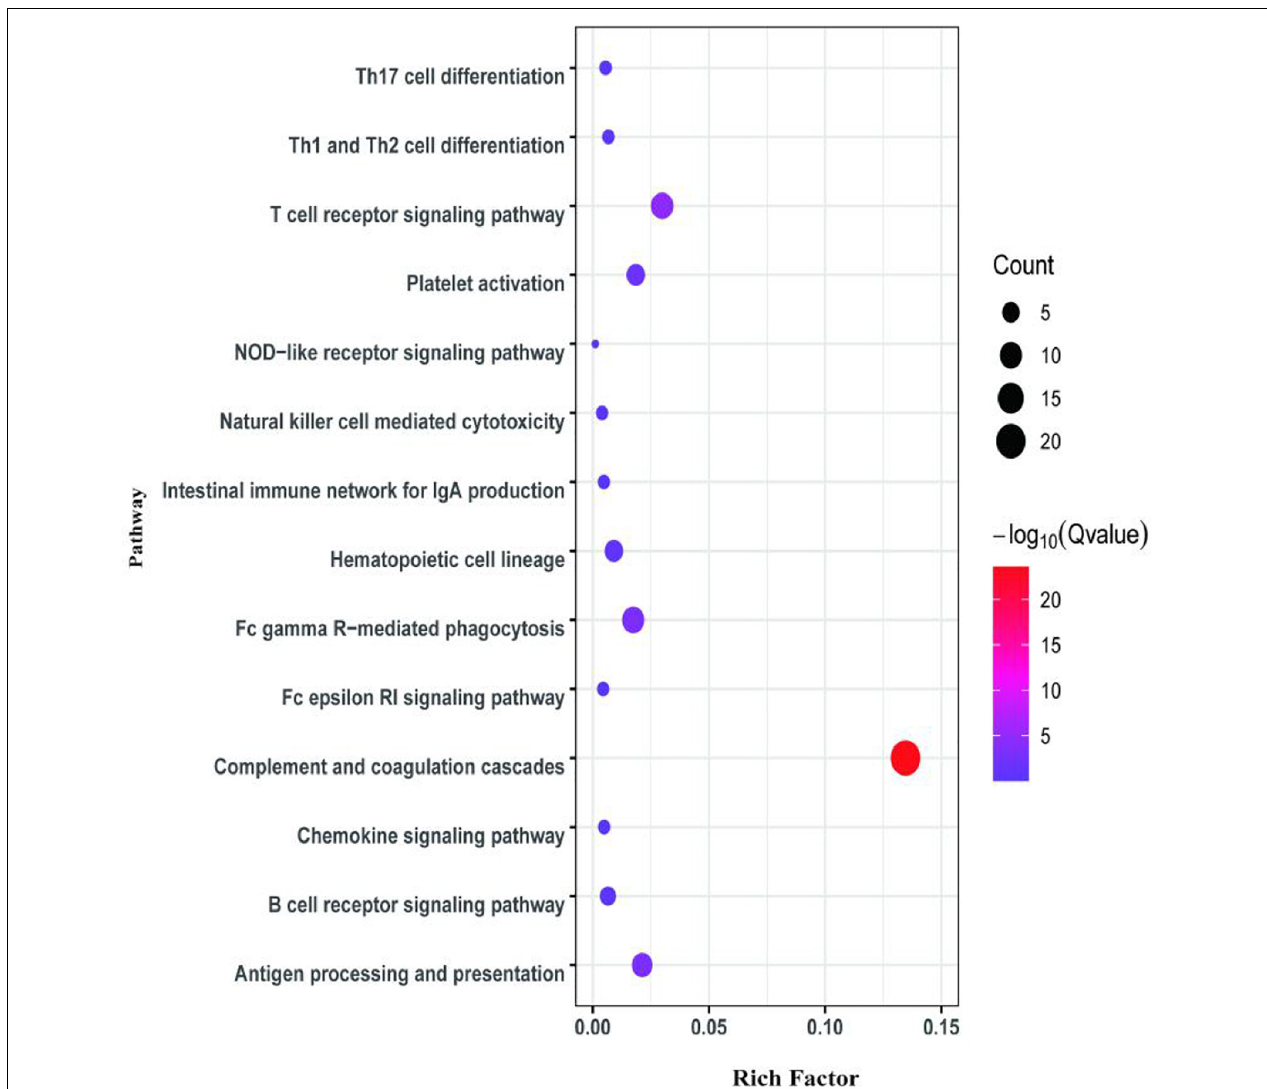
FIGURE 8 | Kyoto Encyclopedia of Genes and Genomes (KEGG) pathway enrichment analysis for differentially expressed mRNAs (DEMs) of the second transcriptome (5 dpi).